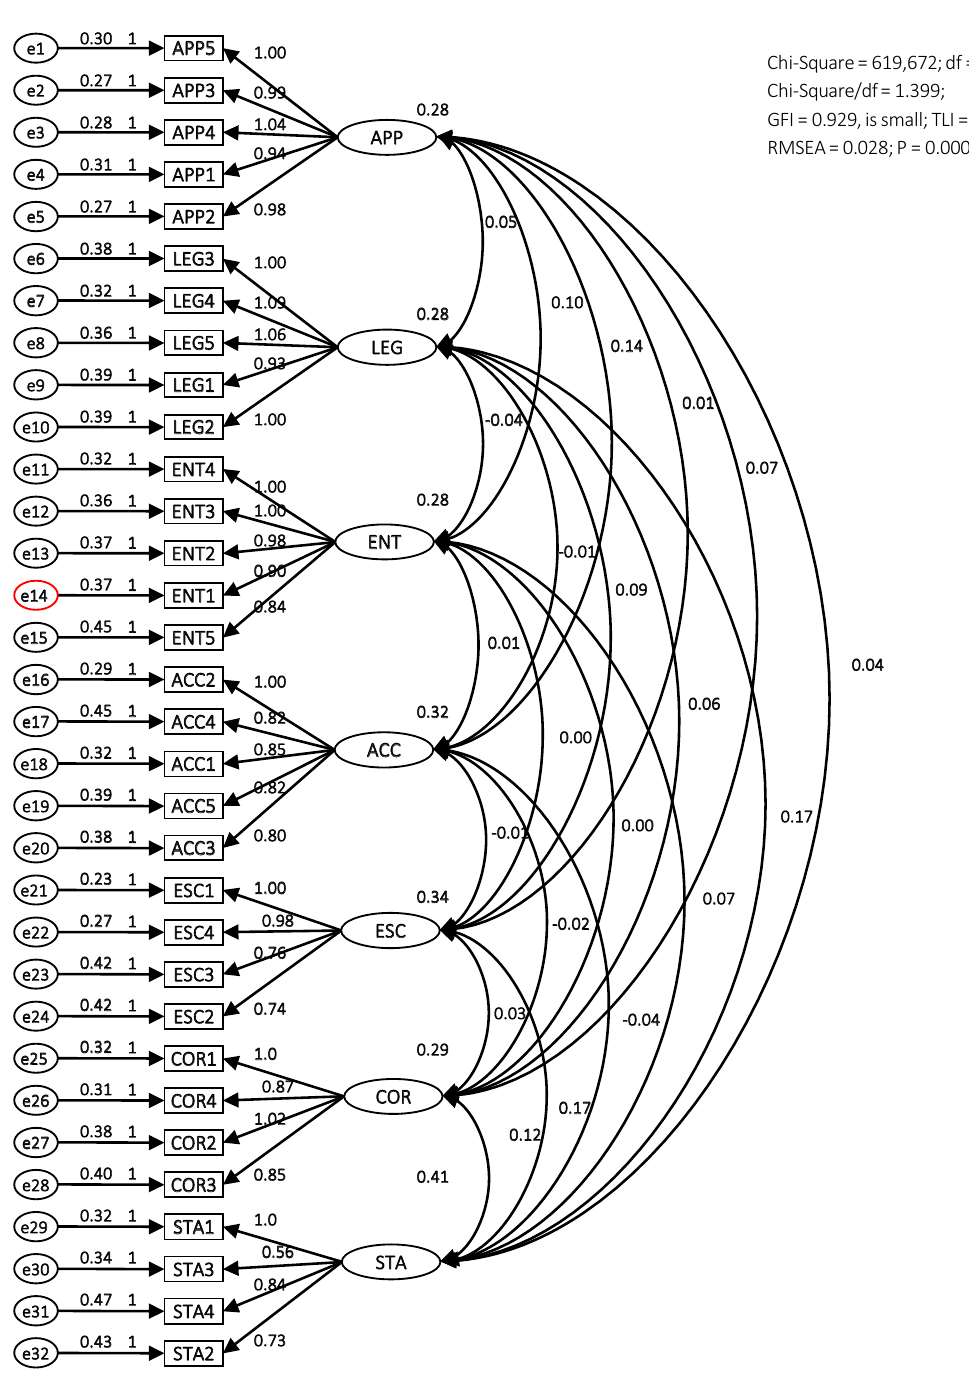
Figure 2. Standardized CFA